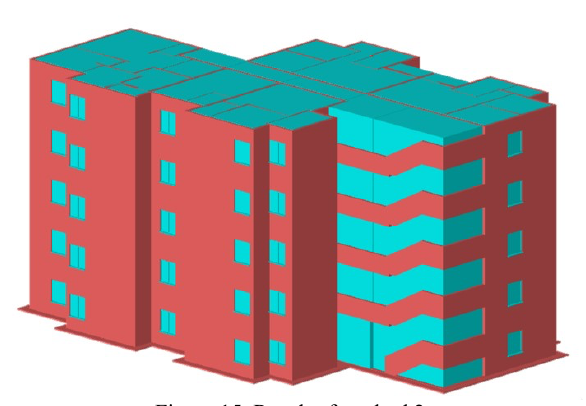
Figure 15. Result of method 2 Regarding legal right representation, both methods have the same output. Figure 16 and 17 show the legal rights of different units on the 4th floor. Figure 16 shows the legal right of unit 5 whereas figure 17 shows the legal right of unit 1.